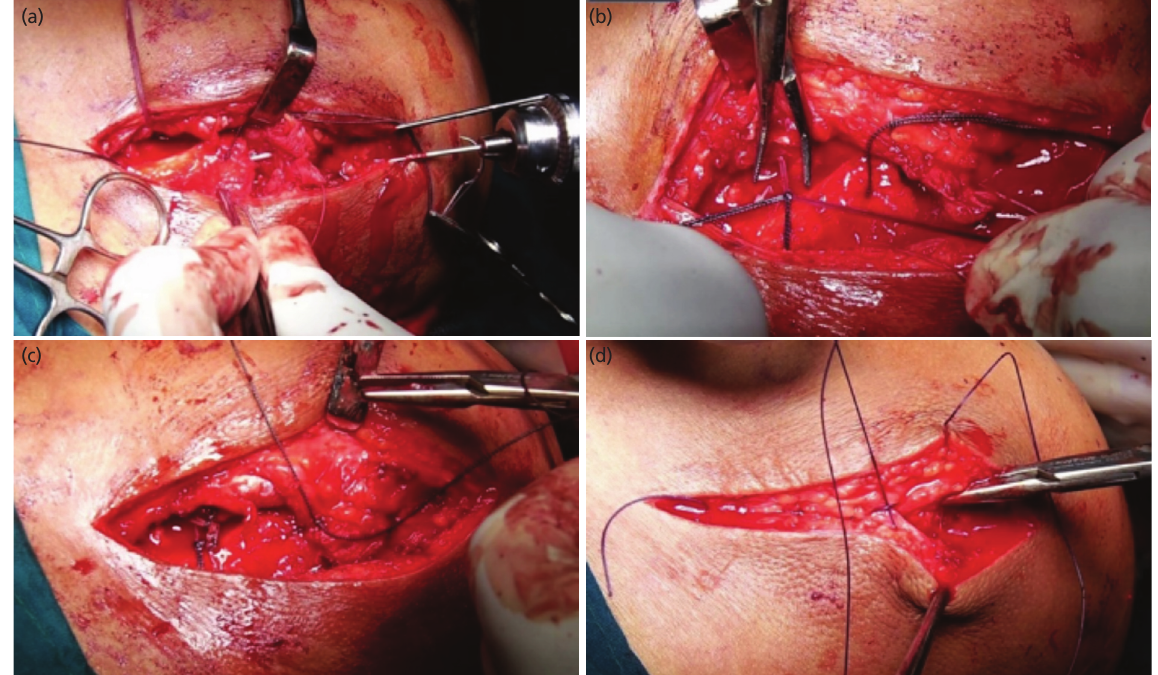
Fig. 2: (a) Intra-operative photograph showing transfixation of acromioclavicular joint with two k wires, (b) tying of suture limbs over the clavicle, (c) repair of acromioclavicular joint capsule and (d) closure of deltotrapezial